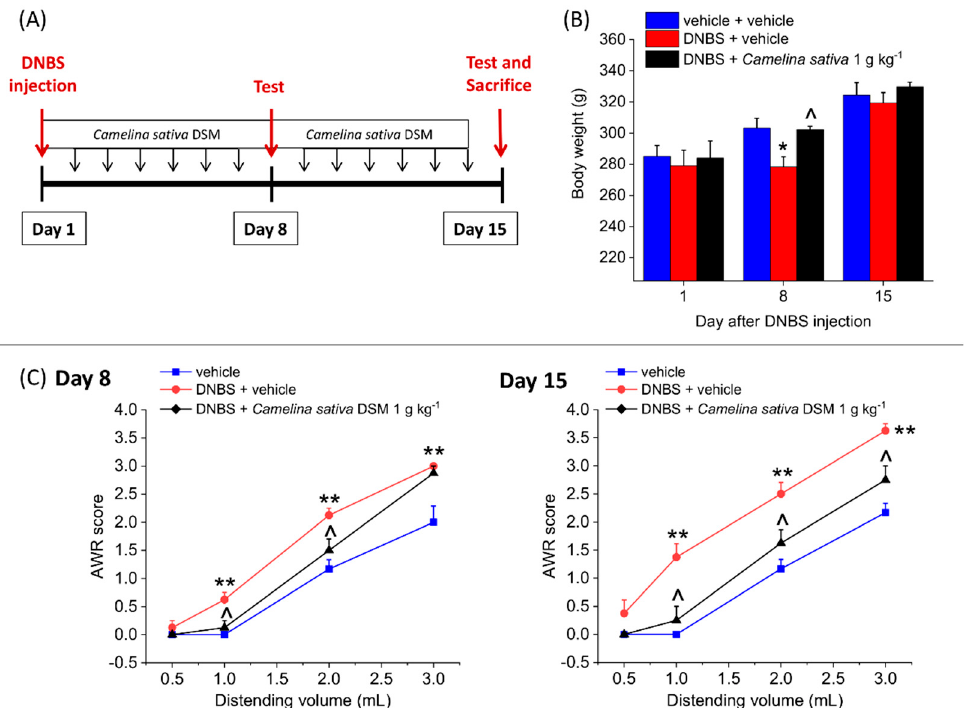
Figure 5. The effects of the repeated administration of Camelina sativa DSM in DNBS-treated rats. ( A ) Experimental scheme: Camelina sativa DSM (1 g kg − 1 ) was administered once daily in the DNBS- treated animals, starting from the day of DNBS injection and continuing the daily treatment for 14 consecutive days. Body weight ( B ) and visceral pain threshold ( C ) were assessed on Days 8 (acute inflammatory phase) and 15 (post-inflammatory phase), 24 h after the last administration. Visceral sensitivity was assessed by measuring the extent of the abdominal withdrawal response (AWR) to colorectal distension (0.5–3 mL). Each value represents the mean ± SEM of six animals per group. * p < 0.05 and ** p < 0.01 vs. vehicle. ^ p < 0.05 vs. DNBS + vehicle.